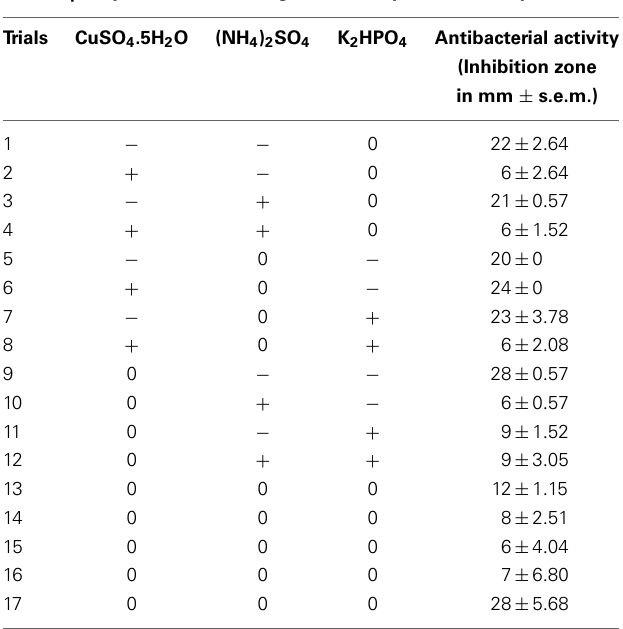
Table 5 | Response surface design and its experimental